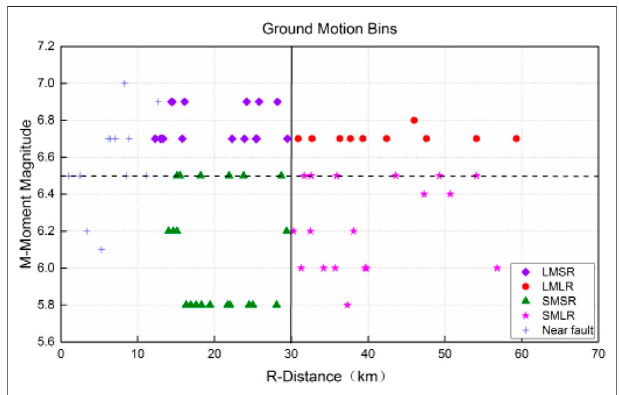
FIGURE 4 | Mw-R distribution of ground motion records.